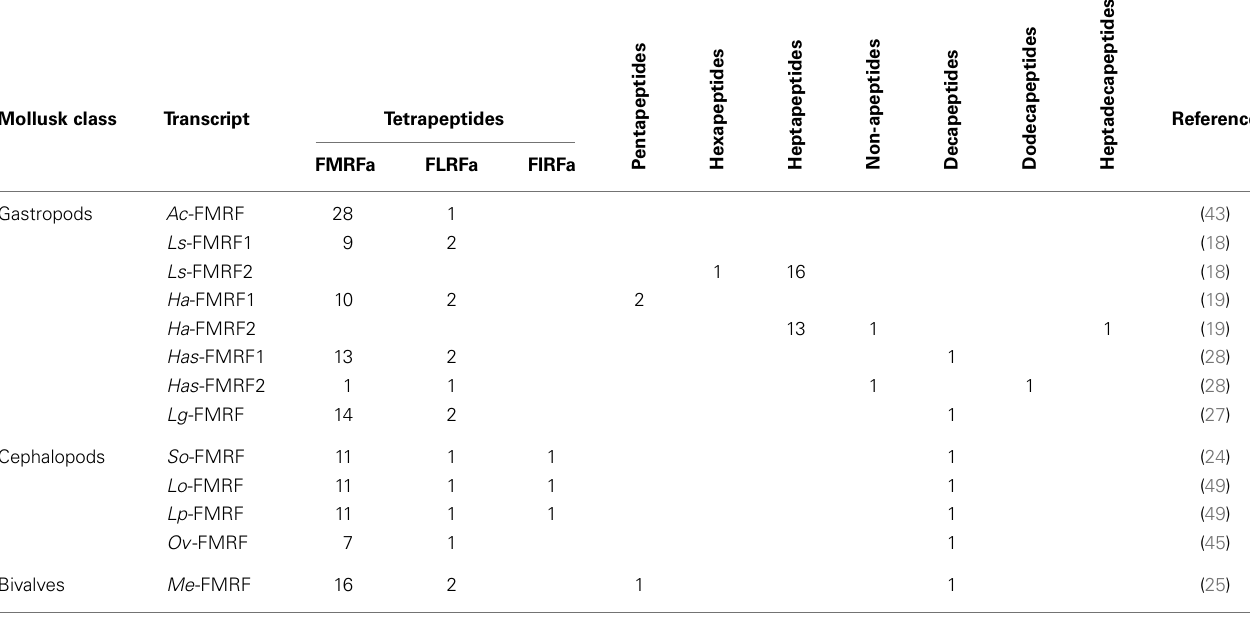
Table 2 | FaRP precursors from different species of mollusks with indication of copy numbers for each peptide category .